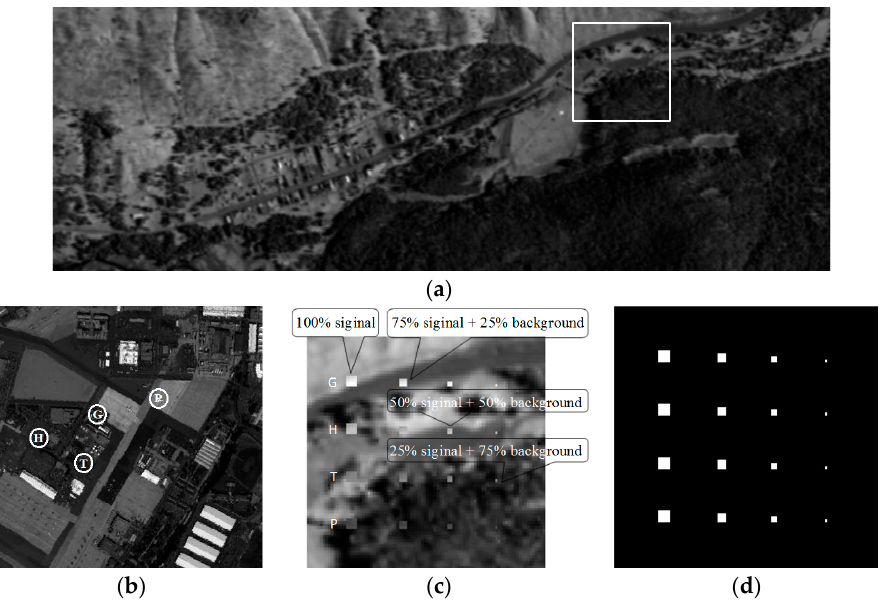
Figure 8. ( a ) HyMap hyperspectral image; ( b ) SanDiego Airport image; ( c ) synthetic image; ( d ) ground truth of synthetic image. truth of synthetic